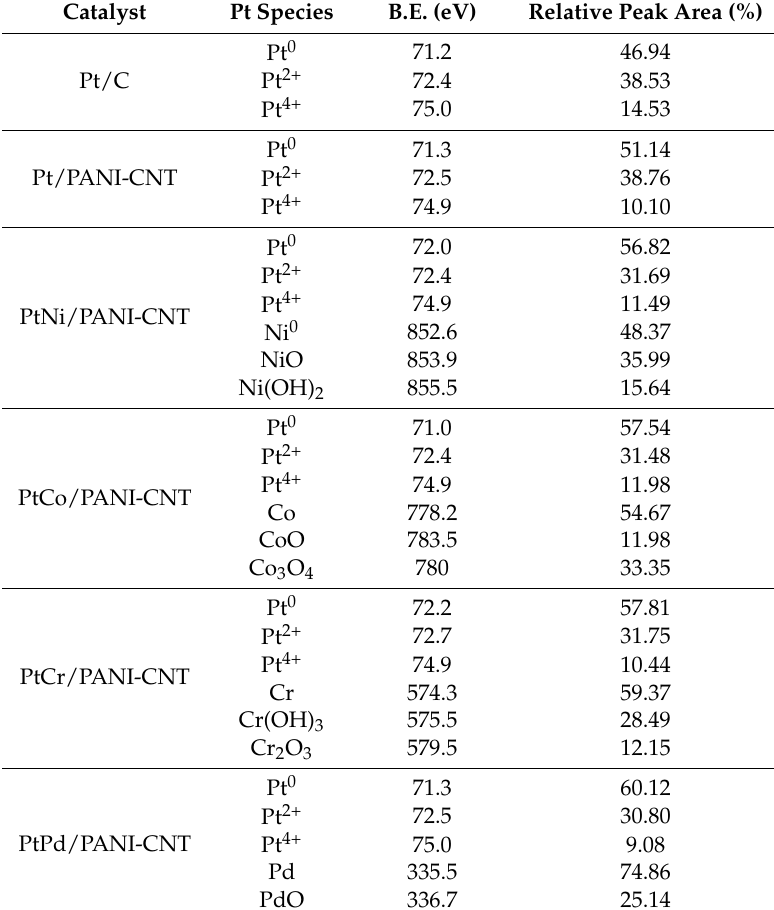
Table 2. Physico-chemical properties of all prepared